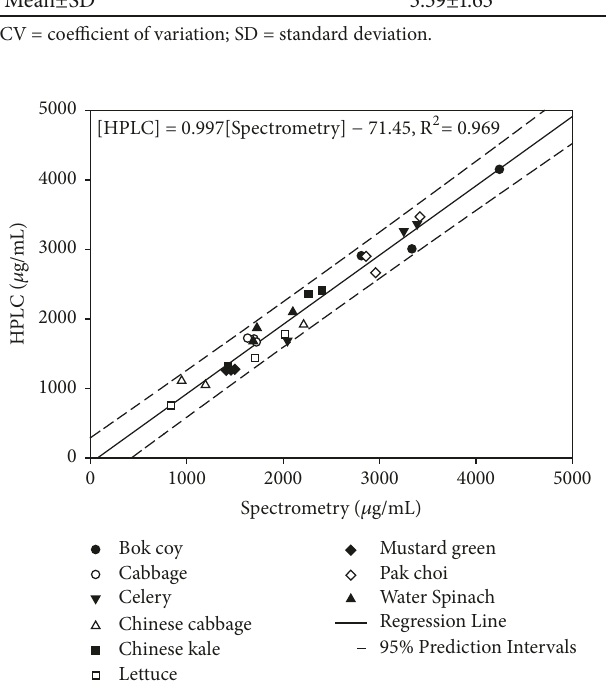
Figure2:Linearregressionforpairsofvegetablenitratedataderived from spectrometry and HPLC. The curved lines represent 95% confidencelimits on an individual predicted HPLC value for a given value of